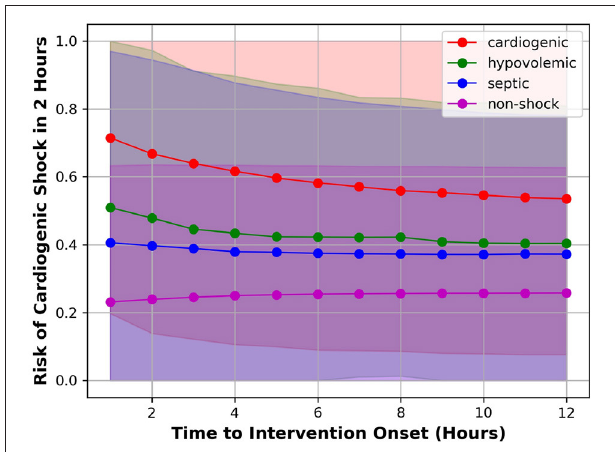
FIGURE 2 | Mean risk of patient having CS (red), hypovolemic shock (green), septic shock (blue), or non-shock